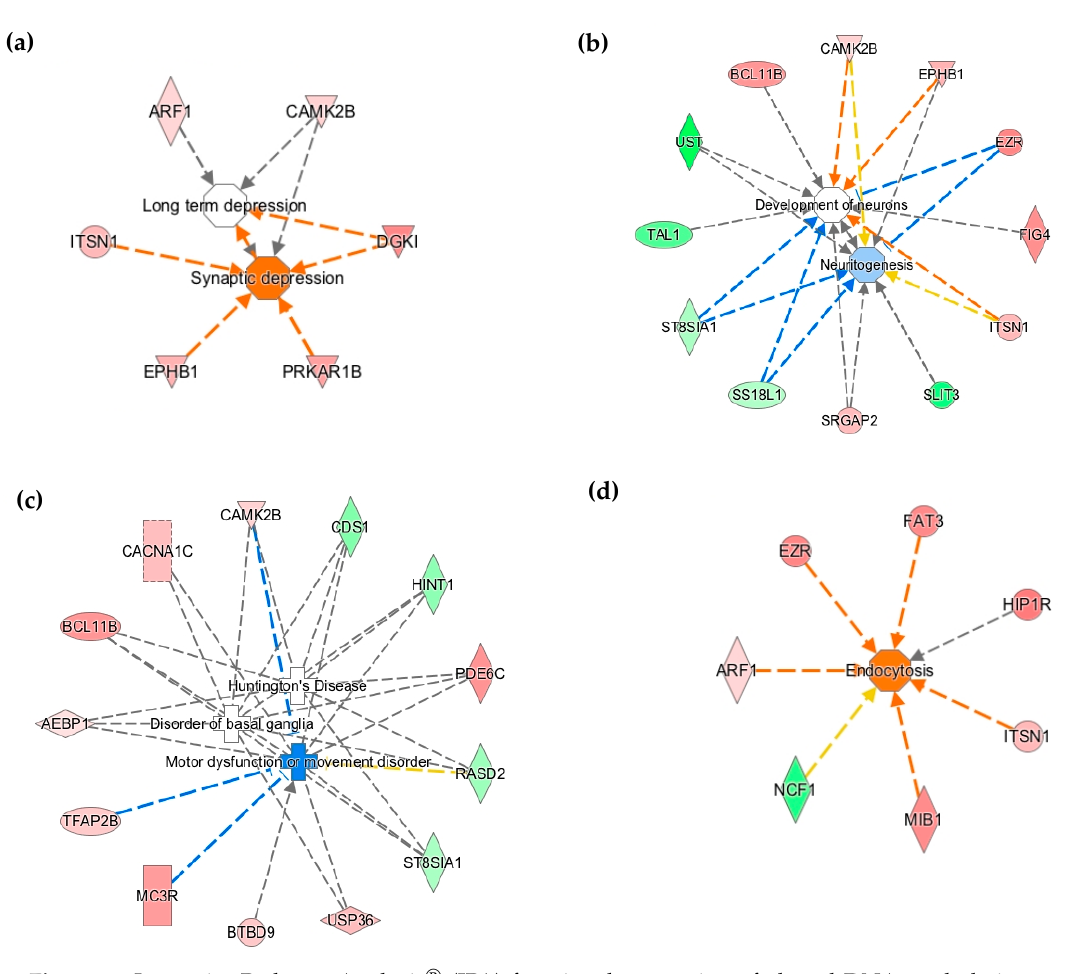
Figure 2. Ingenuity Pathway Analysis ® (IPA) functional annotation of altered DNA methylation at loci that are involved in ( a ) synaptic depression, ( b ) neuritogenesis and neuronal development, ( c ) pathogenesis of neurological diseases, and ( d ) lipid metabolism and molecular transport, including endocytosis. Red-filled and green-filled shapes indicate increased and decreased methylation, respectively. Orange-red lines indicate activation; blue lines indicate inhibition; yellow lines indicate findings inconsistent with the state of downstream activity; grey lines indicate that the effect was not predicted. Table 5. Overlapping genes of the P15 DNA methylome and microarray Table 3. Overlapping canonical pathways of the P15 DNA methylome and P15 microarray datasets.